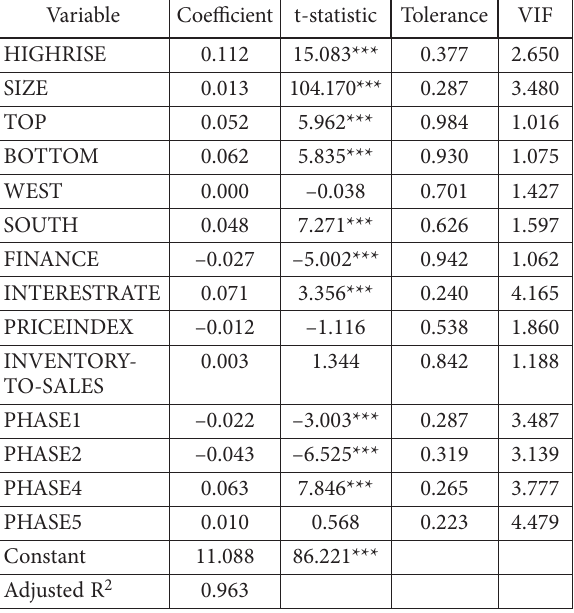
Table 4. Price estimation